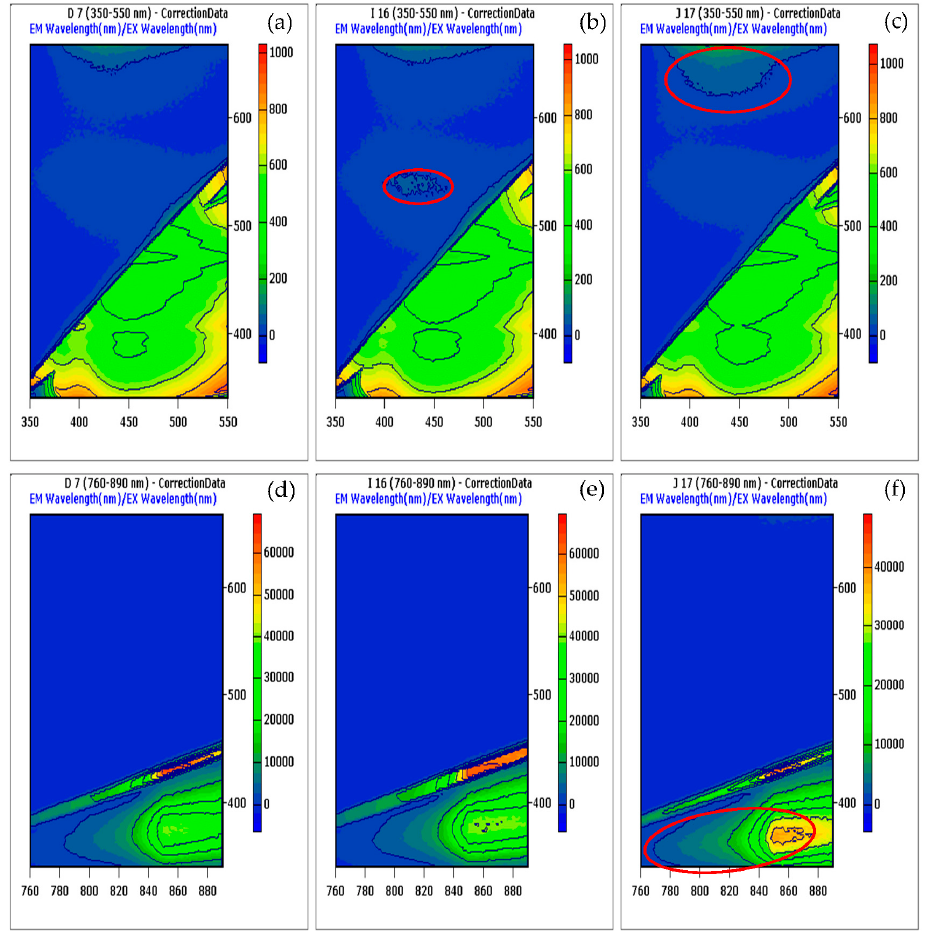
Figure 5. Contour map of the emission excitation matrix (EEM) of select beer samples (D7, I16 and J17). The color bar ranging from low (blue) to high (red) shows the signal intensity for each sample is shown. ( a ) Sample D7 at emission range 350 to 550 nm and excitation range from 340 to 890 nm; ( b ) sample I16 at emission range 350 to 550 nm and excitation range from 340 to 890 nm; ( c ) J17 at emission range 350 to 550 nm and excitation range from 340 to 890 nm; ( d ) at emission range 350 to 550 nm and excitation range from 340 to 890 nm; ( e ) Sample I16 at emission range 760 to 890 nm and excitation range from 340 to 890 nm; ( f ) sample J17 at emission range 760 to 890 nm and excitation range from 340 to 890 nm.